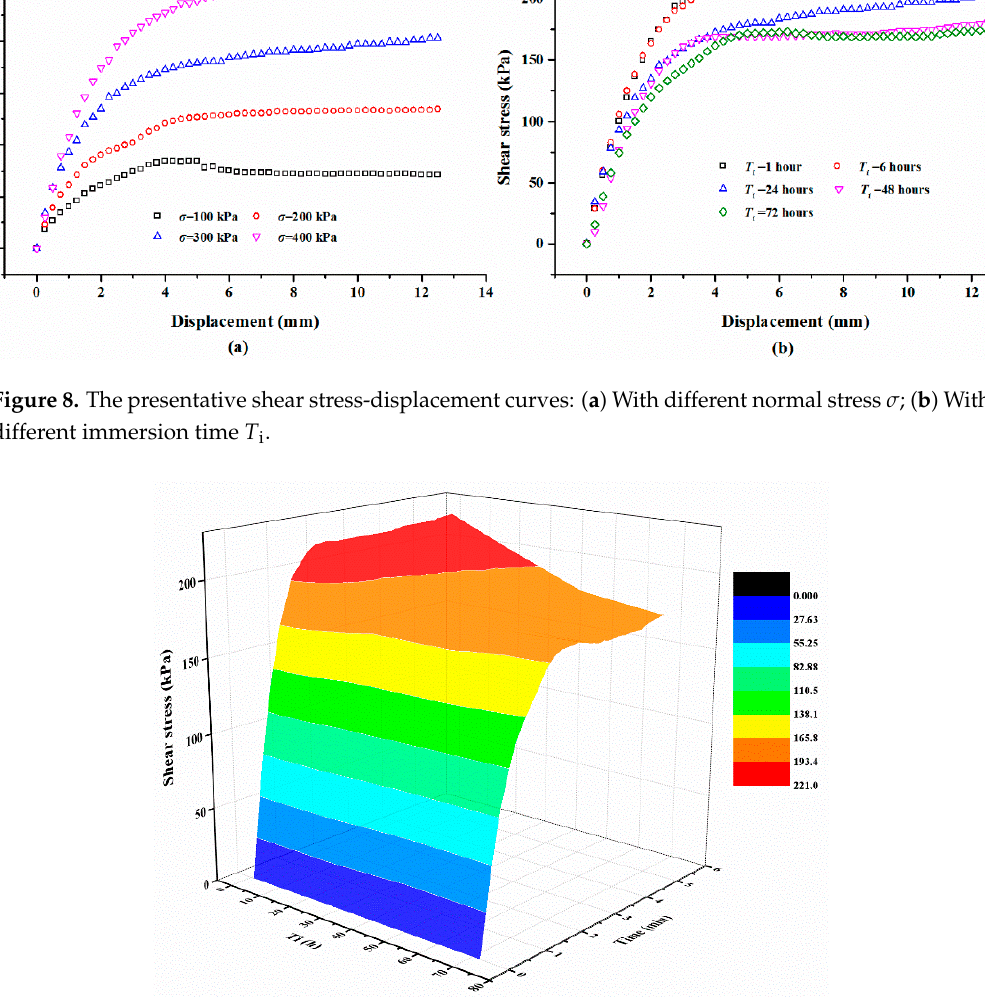
Figure 10. ( a ) The variation of the shear strength τ and normal stress σ ; ( b ) The variation of the shear strength parameters ( c and φ ) and immersion time T i . 3.2.3. The Effect of Polymer Content on Shear Behaviors The polymer content may play a vital role in the stability of the polymer membrane and it significantly influences the strength of the polymer-sand composite material. Thereby, the polymer content in the prepared specimen varies from 1% to 5% with an increment of 1%. The typical shear stress-displacement curves of the mixture specimen with various normal stresses are given in Figure 11a. It can be seen that the shear stress of the mixture with a normal stress of 100 and 200 kPa increases